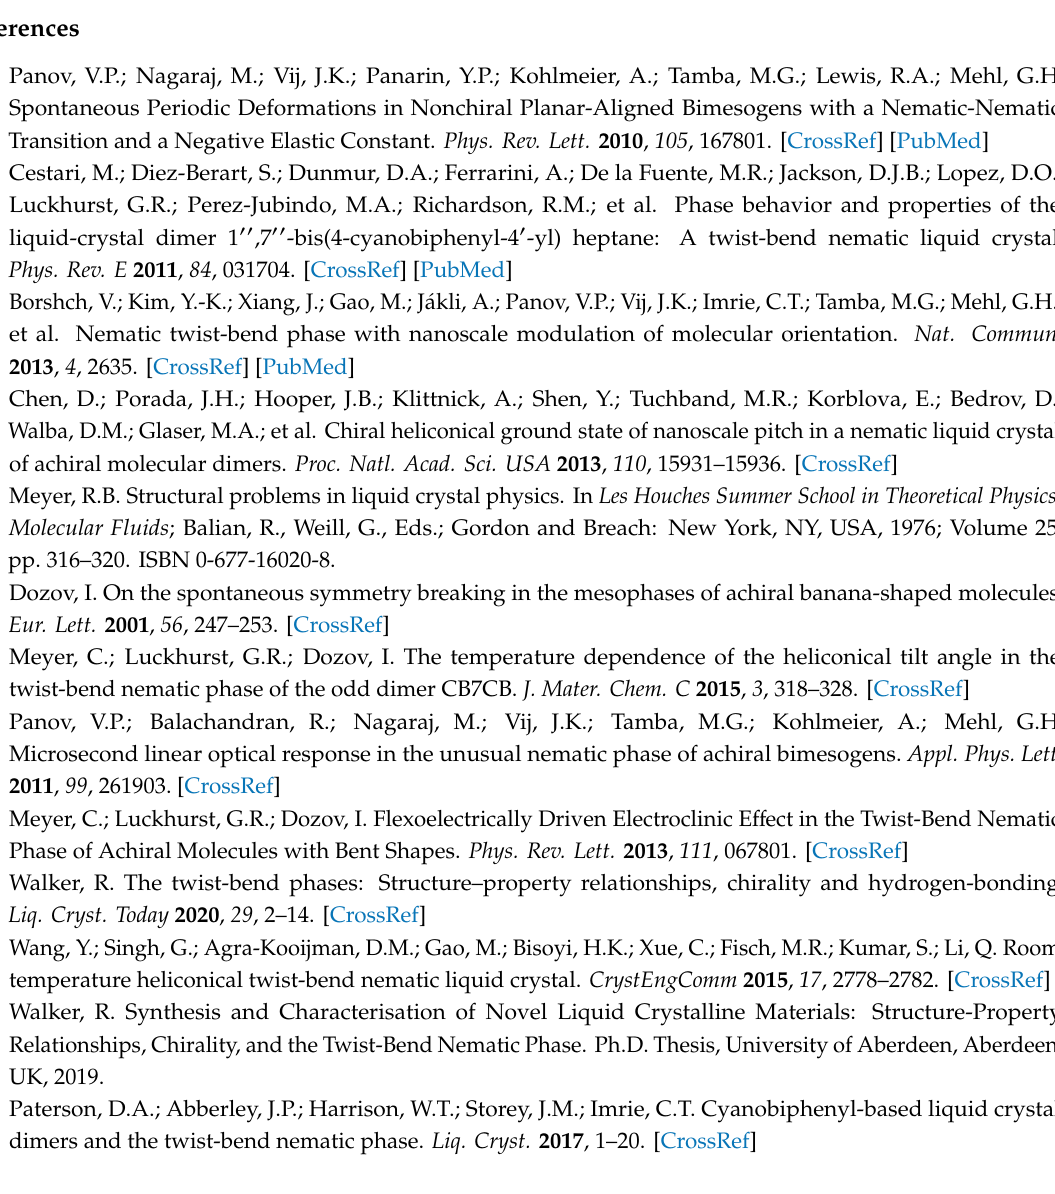
Figure S1. Polarizing optical micrographs of CB7CB observed at di ff erent temperatures in a planar cell. Figure S2. Growth of needle crystals in the N TB phase of CB7CB at 95 ◦ C in a planar cell Figure S3. X-rays di ff racted intensities of 8CB / CB7CB mixtures as a function of wave vector q . Figure S4. POM of the N TB phase of a 8CB / CB7CB mixture ( φ = 25 wt %) at − 20 ◦ C. Figure S5. Contact experiments at room temperature of various smectogens-(a) 8OCB, (b) 10CB, (c) 8CB- with CB7CB. Figure S6. Partial phase diagram of the 8OCB / CB7CB binary system. Figure S7. Destabilization at 26 ◦ C of the N TB phase towards needle crystals and a N phase. Figure S8. Heat flow curves of pure CB7CB and of a φ = 43 wt % mixture. Figure S9. POM texture of N TB phase at room temperature of the 8CB / CB7CB binary system at φ =